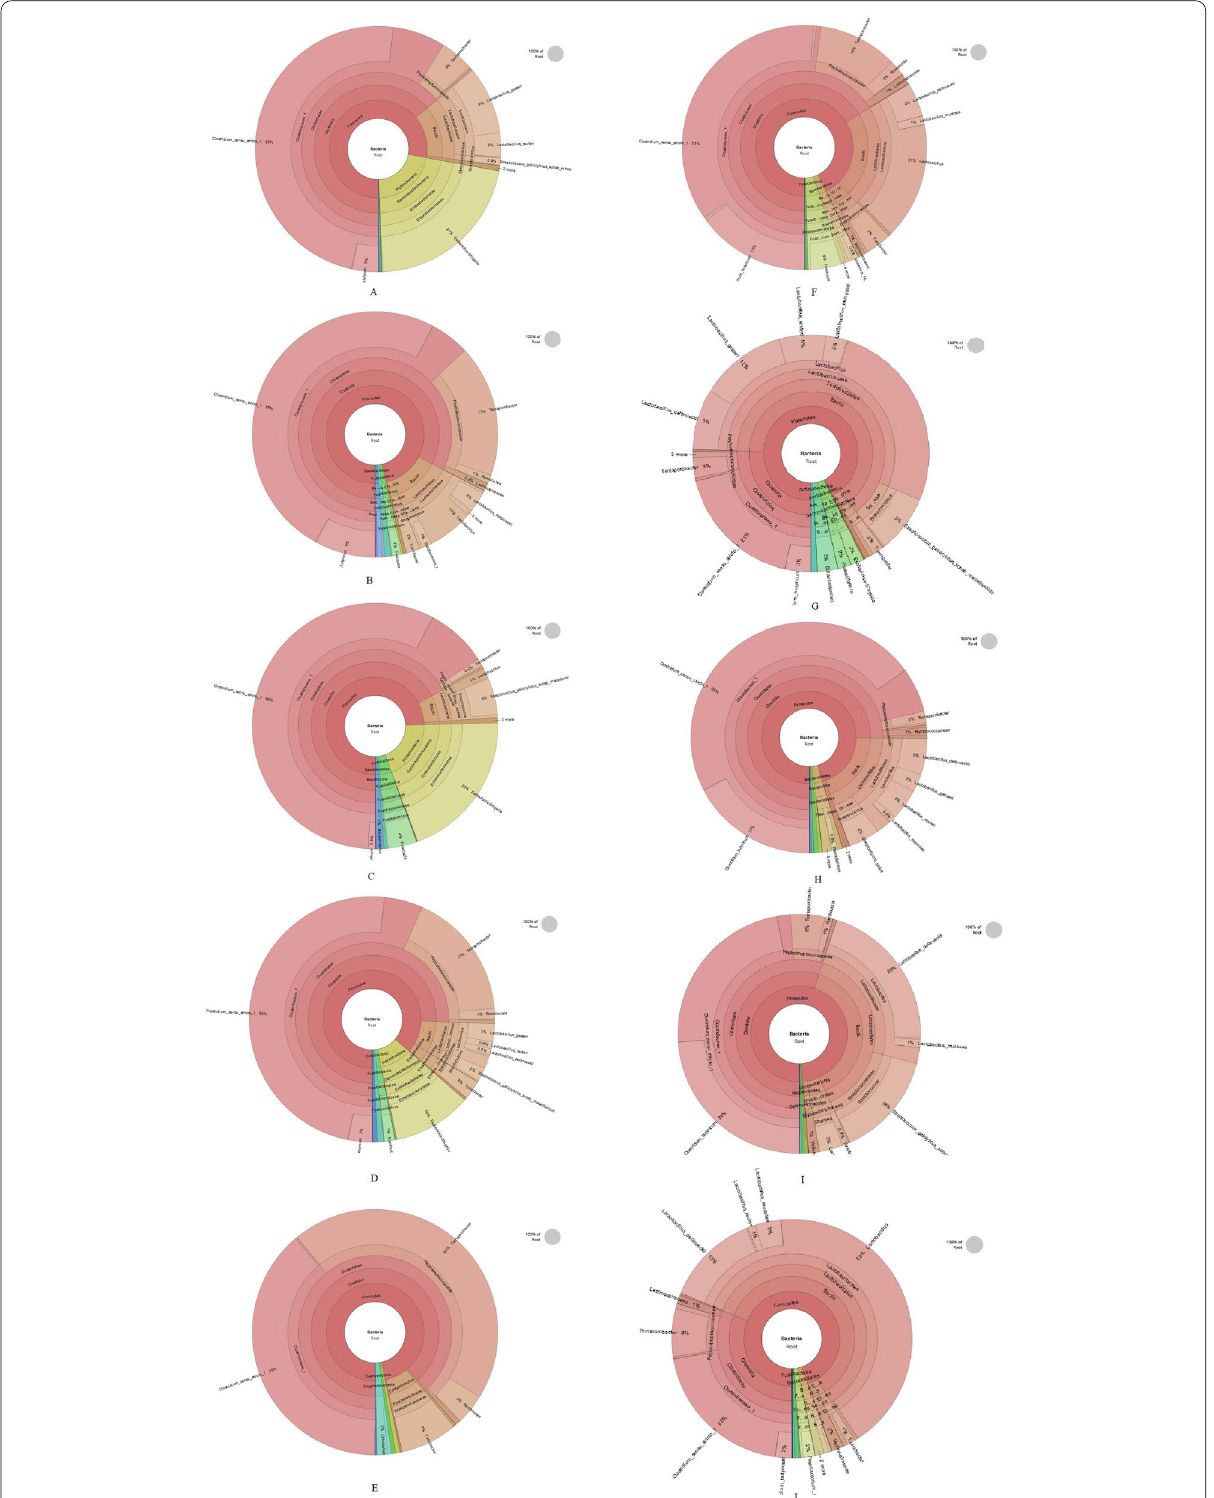
Fig. 2 Krona pie charts of ileal microbial compositions for the five sample in control group ( A – E ) and the five samples in ROD polyphenol extract group ( F – J ). The diagram shows different taxonomic levels of ileal microbial compositions including domain, phylum, class, order, family, genus and species from the center to the outside. The fan-shaped area corresponds to the relative abundance of corresponding